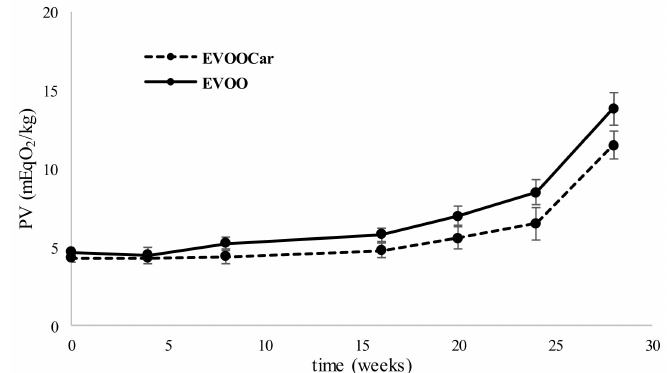
Figure 2. Trend of peroxide value (PV) (meq O 2 / kg oil, mean values) of EVOO and EVOOCar during long-term storage. Error bars refer to the standard deviations ( n =